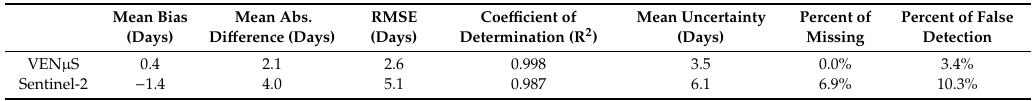
Table 1. Statistics of termination dates from VEN µ S and Sentinel-2 over 29 harvest / termination events in